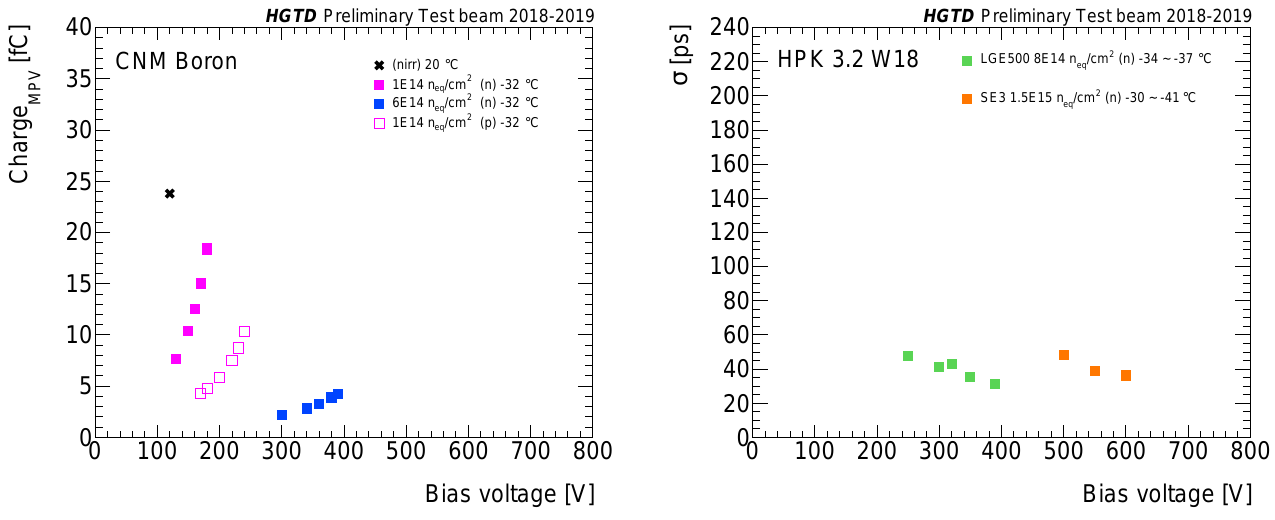
Fig. 8: Collected charge as a function of the the bias voltage for different single pad sensors built by CNM [10].